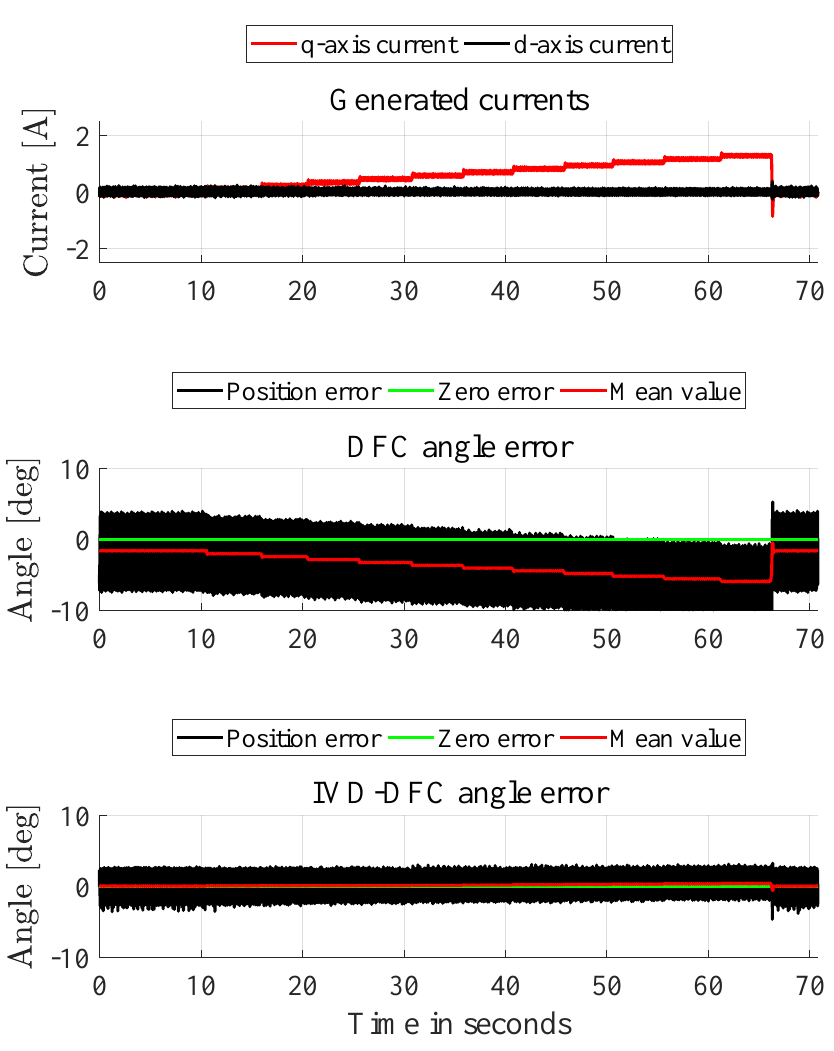
Figure 16. Current steps with increasing amplitude are generated on the q-axis of the mo- tor when the external servo-motor drives the PMSM at 300 RPM. The electrical angle error of the DFC algorithm is compared with the IVD-DFC